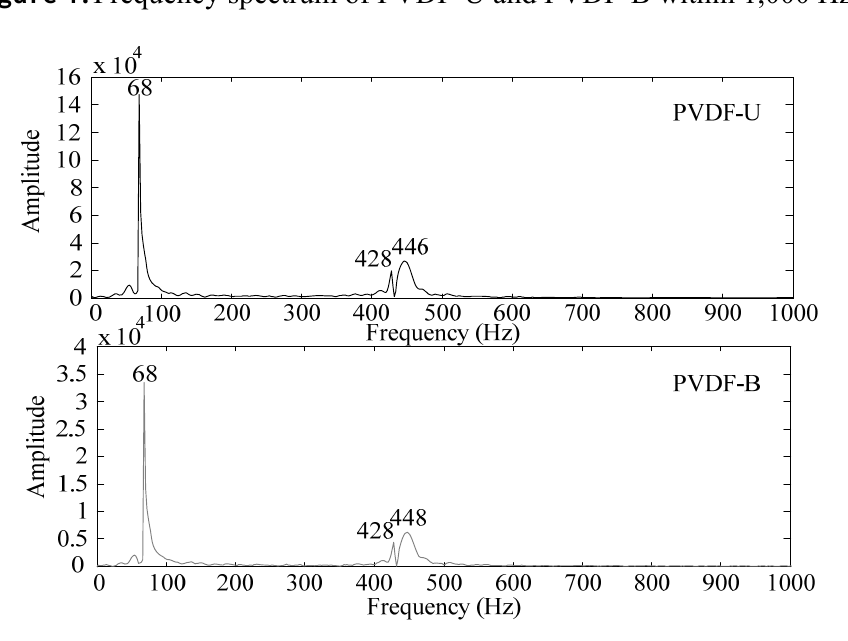
Figure 5. Frequency spectrum of PVDF-U and PVDF-B from 1,000 to 10,000